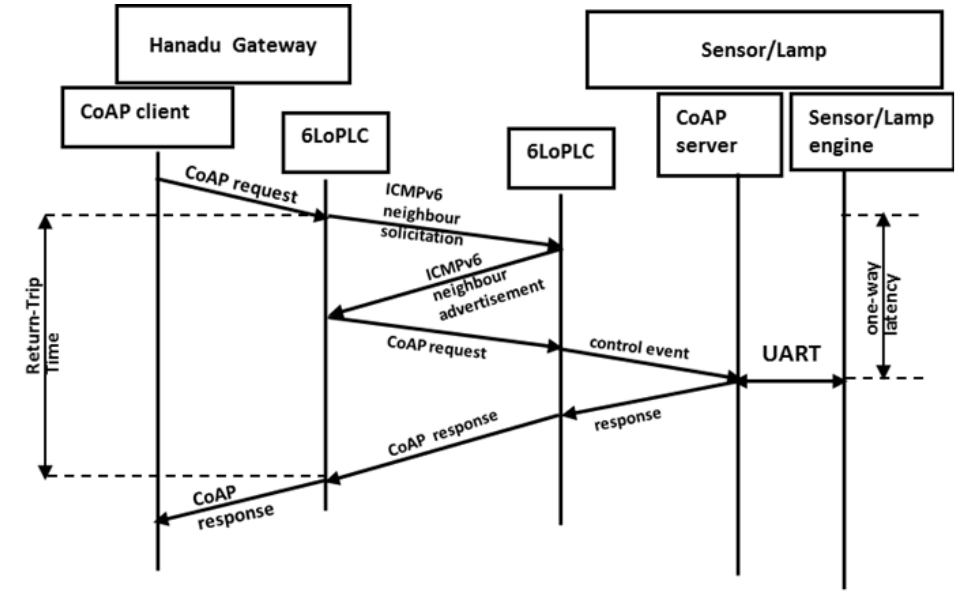
Figure 6. A schematic showing the end-to-end